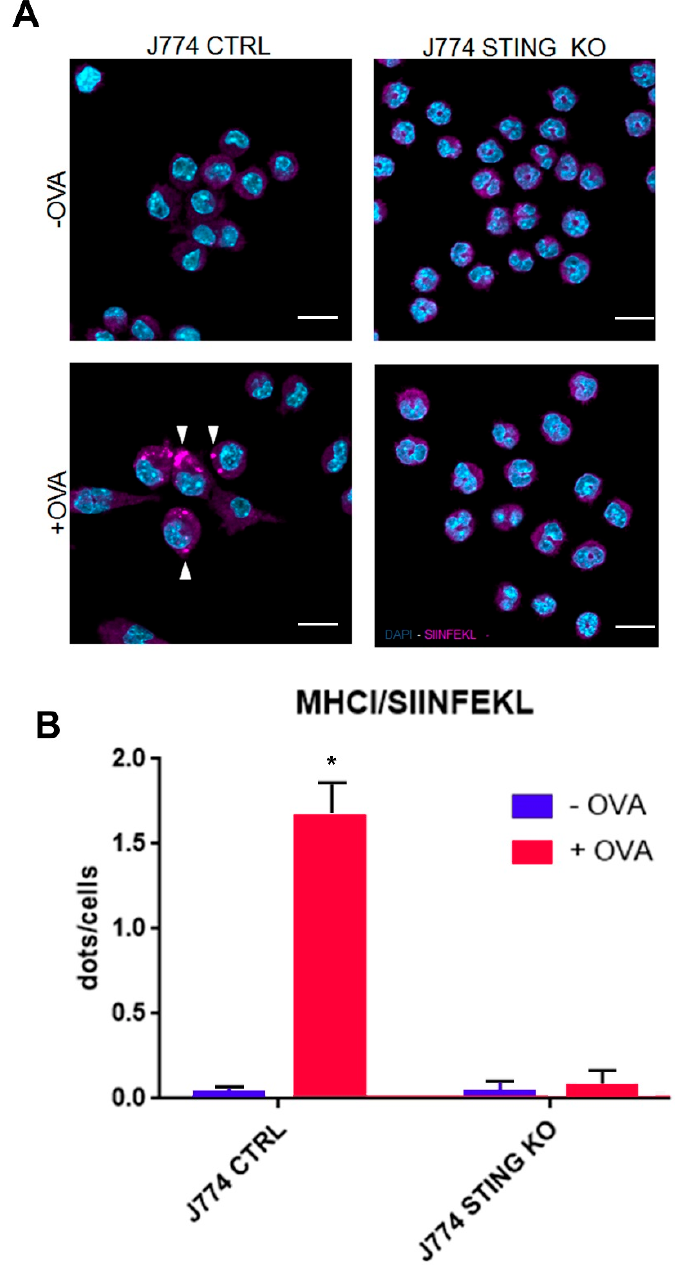
Figure 3. Peptide loading is impaired in STING KO macrophages. ( A ) J774 CTRL and STING KO cells (2 × 10 5 ) were treated with 500 µ g/mL of OVA for 24 h and stained with anti-MHC-I/SIINFEKL. Nuclei were stained with DAPI. Arrows indicate MHCI/SIINFEKL complexes. The original mag- nification is 20 × and white scale bars represent a length of 5 µ m. ( B ) A quantification analysis of MHCI/SIINFEKL dots was carried out by using a sample of 150 cells from three independent experiments. The asterisks indicate a statistically significant difference compared to the untreated control, according to a Student’s t -test ( p <